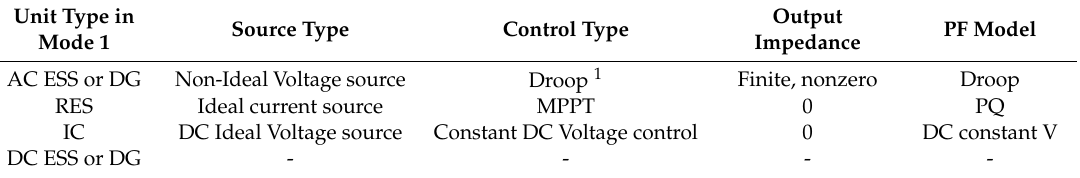
Table 1. The electrical behavior of the main components of IHMG in mode 1.